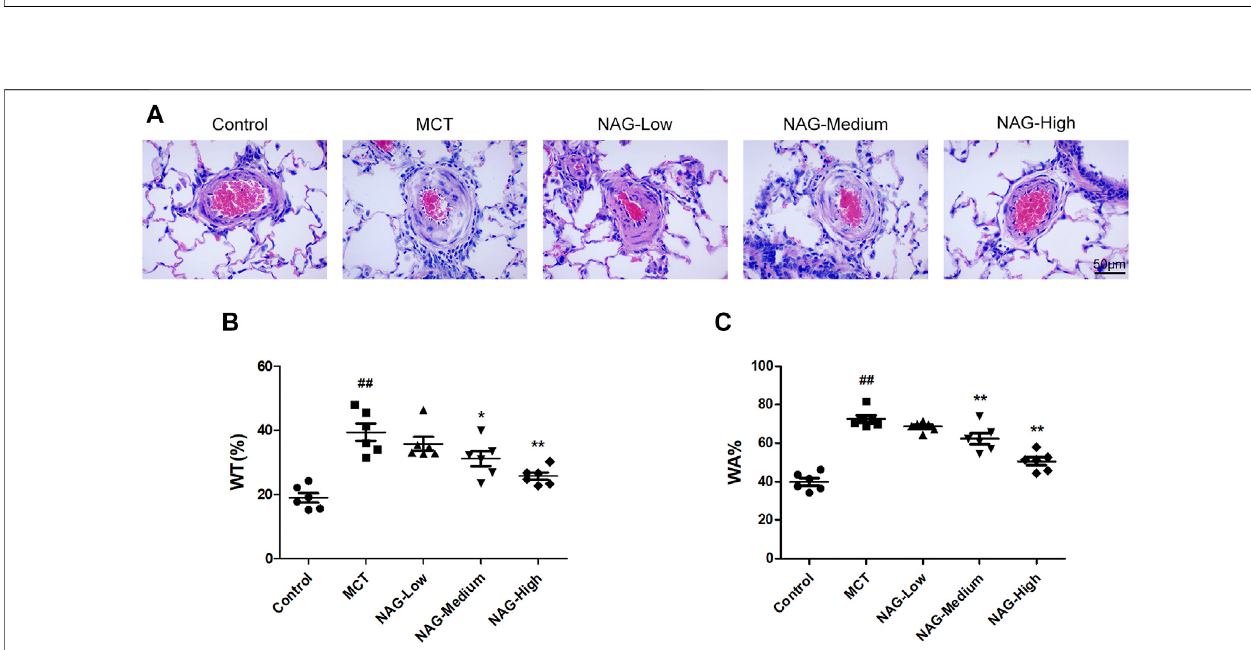
FIGURE2 | Effects of naringin on pulmonary arterial remodeling in thePAH caused by MCT administration. (A) Representative histopathological images ofrat PAs by H&E staining. Magni fi cation, × 400; scale bars, 50 µm. Quanti fi cations for (B) wt% and (C) WA%. ## p < 0.01 vs. control; * p < 0.05, ** p < 0.01 vs. MCT. n (cid:1) 6.